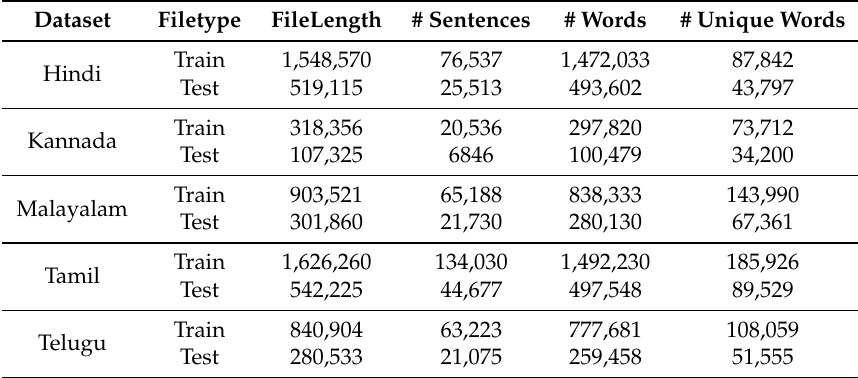
Table 1. Data set